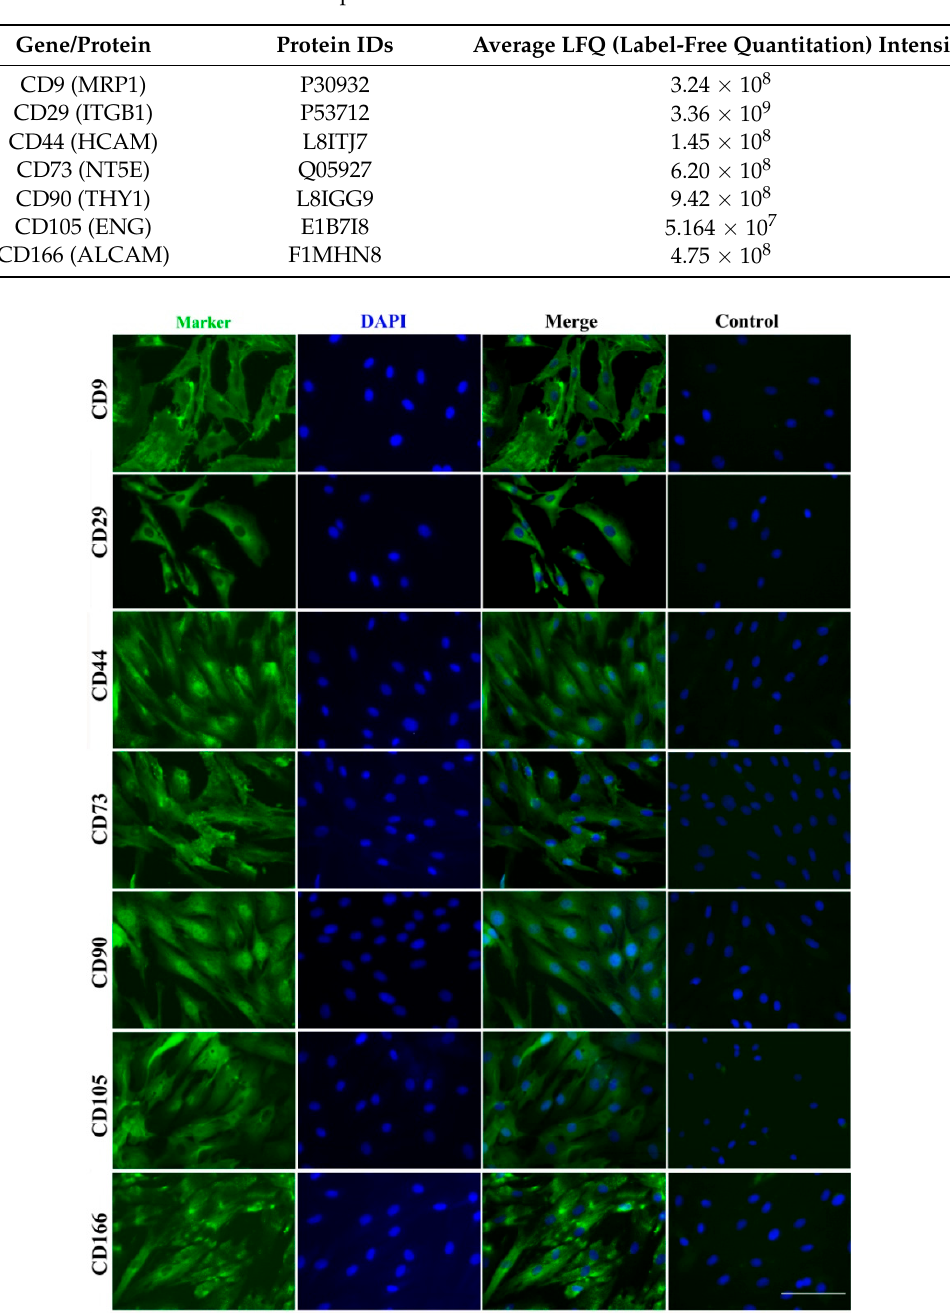
Table 2. Expression of stem cell surface markers.